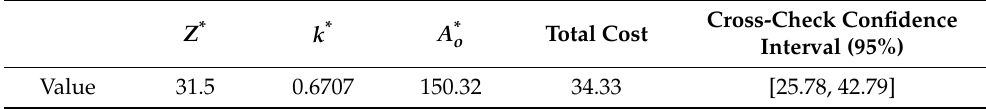
Table 6. Optimal control parameters.